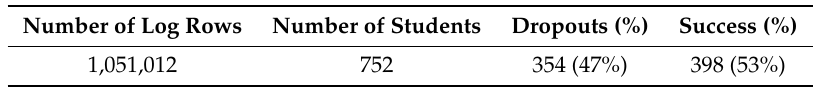
Table 1. Dataset